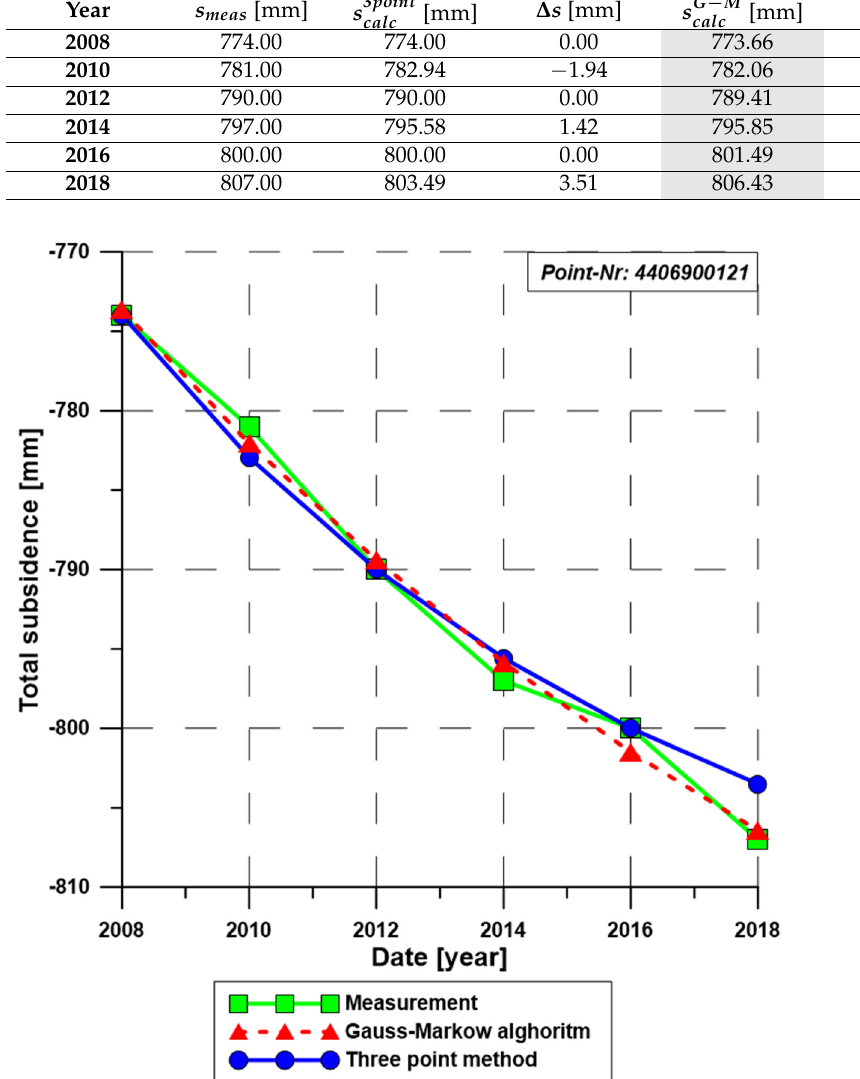
Figure 11. Comparison of the results of the three-point method and the Gauss–Markov algorithm for the point No. 121. the point No.